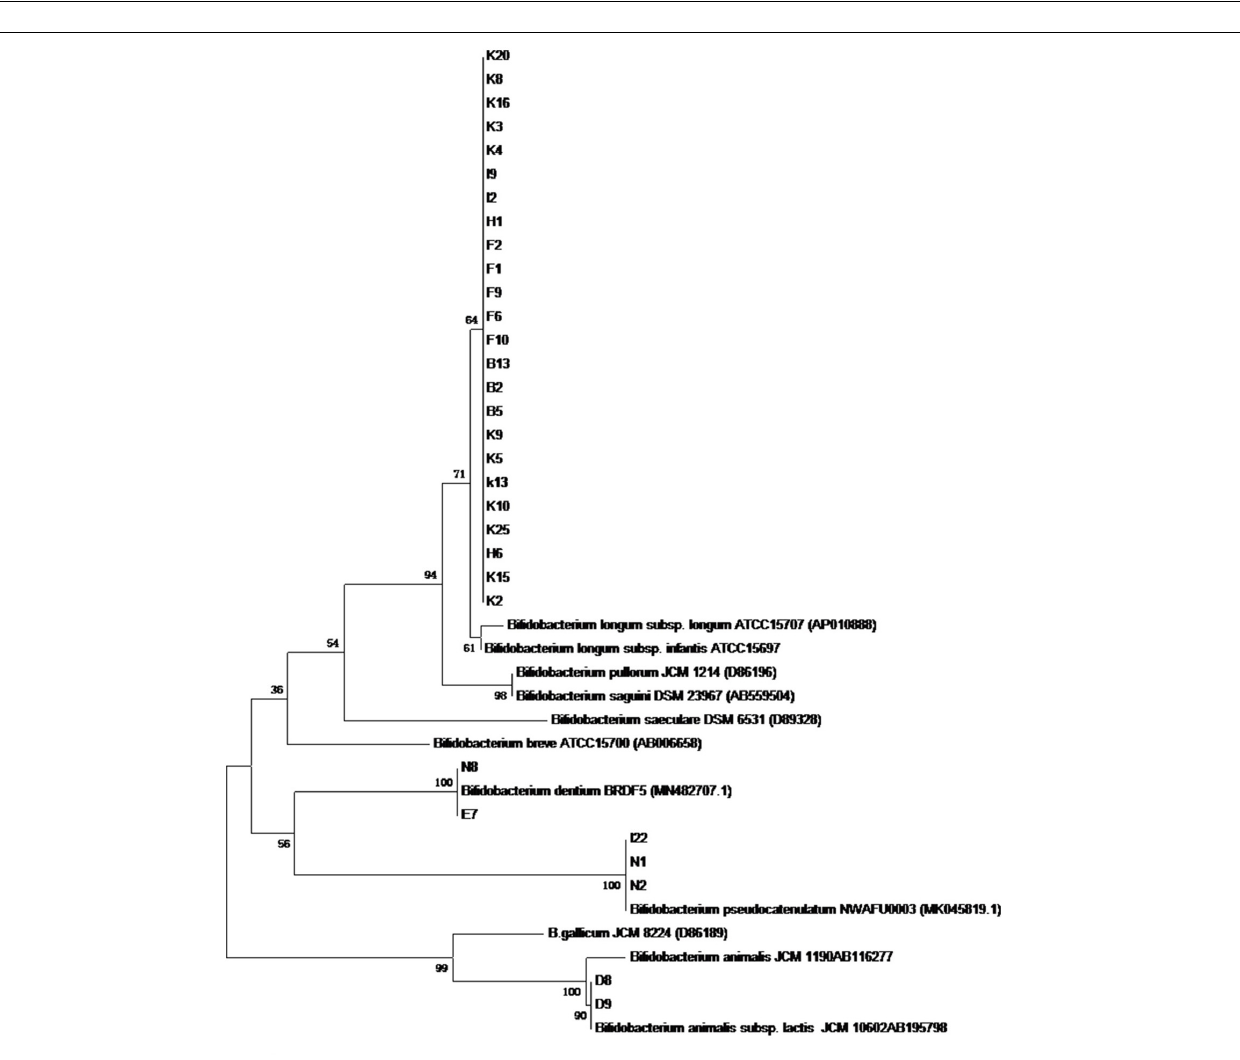
Frontiers in Microbiology |